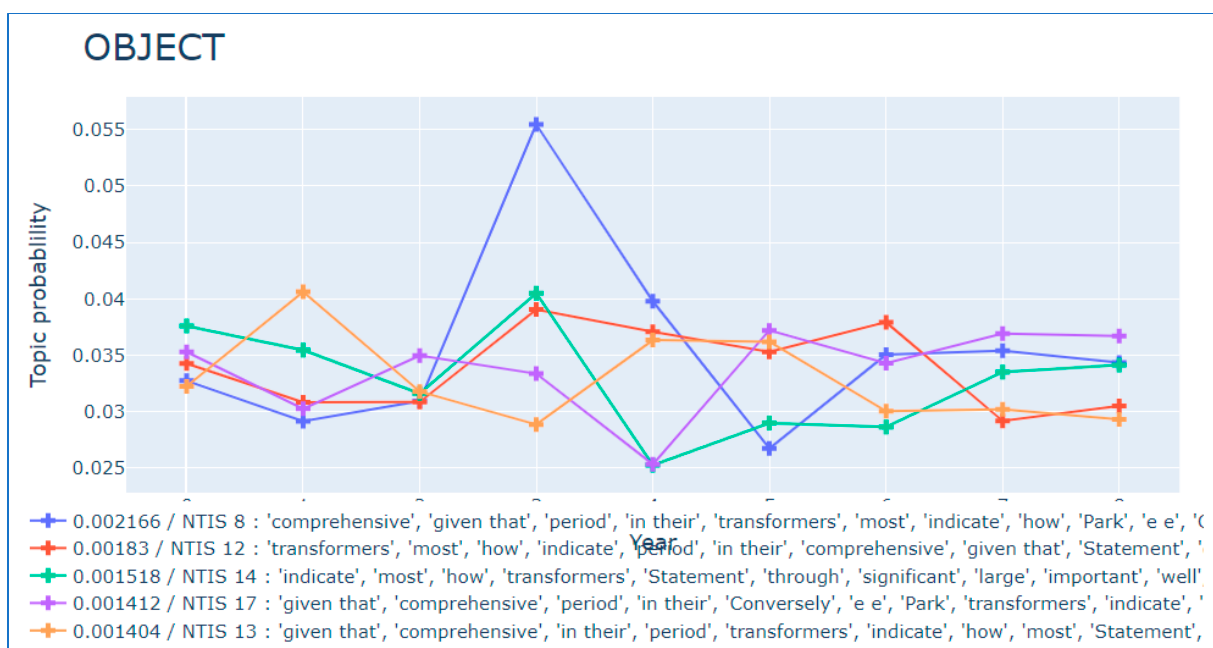
Figure 9. DTM OBJECT topic probability.